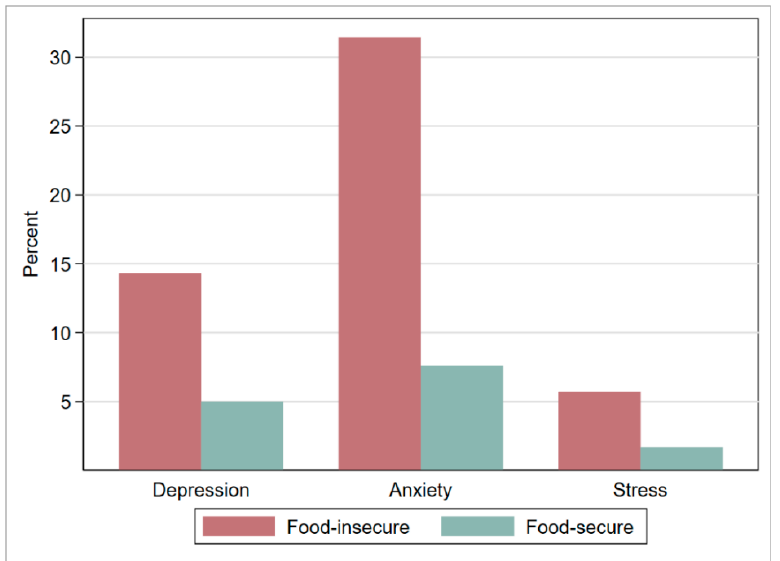
Figure 2. Proportion (percentage) of depression, anxiety, and stress among early-gestation pregnant women in Matlab, after matching (weighted), by household food security status.